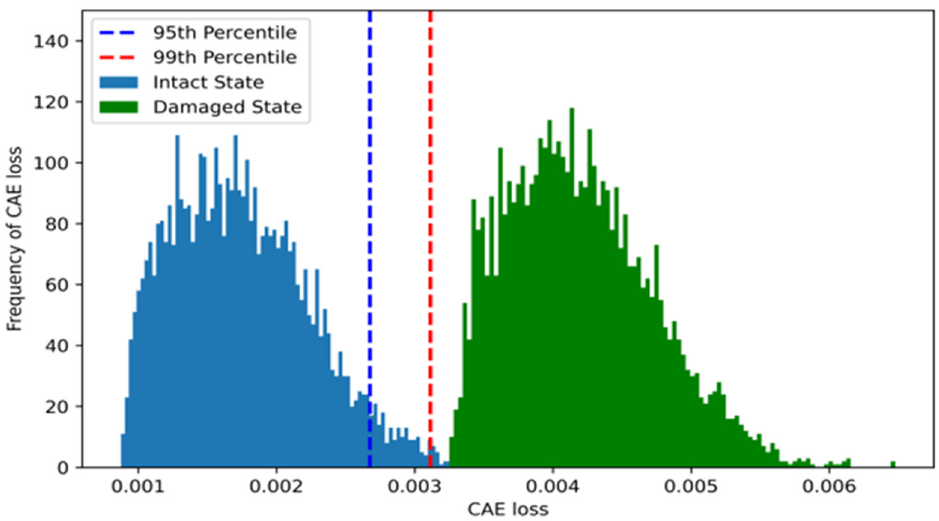
Figure 13. Example of histograms of CAE losses for RC-slab-bridge modeling.